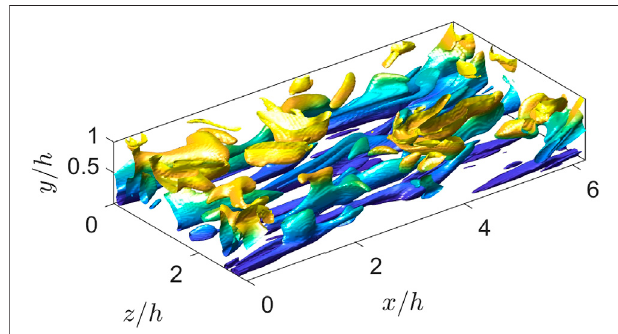
FIGURE 1 | Reyhnolds-stress structures at the bottom half of the channel.Thestructuresarecolouredbywall-normaldistance.The fl owmoves from the left to the right of the fi